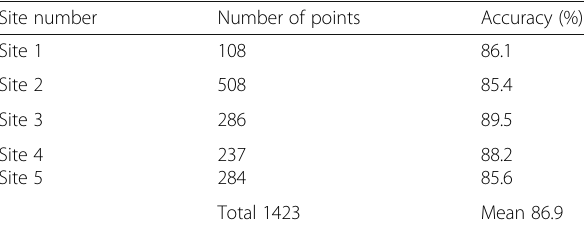
Table 1 The number of points collected to determine classification accuracy of tanglehead ( Heteropogon contortus ) at five study sites in Jim Hogg and Duval Counties, Texas,